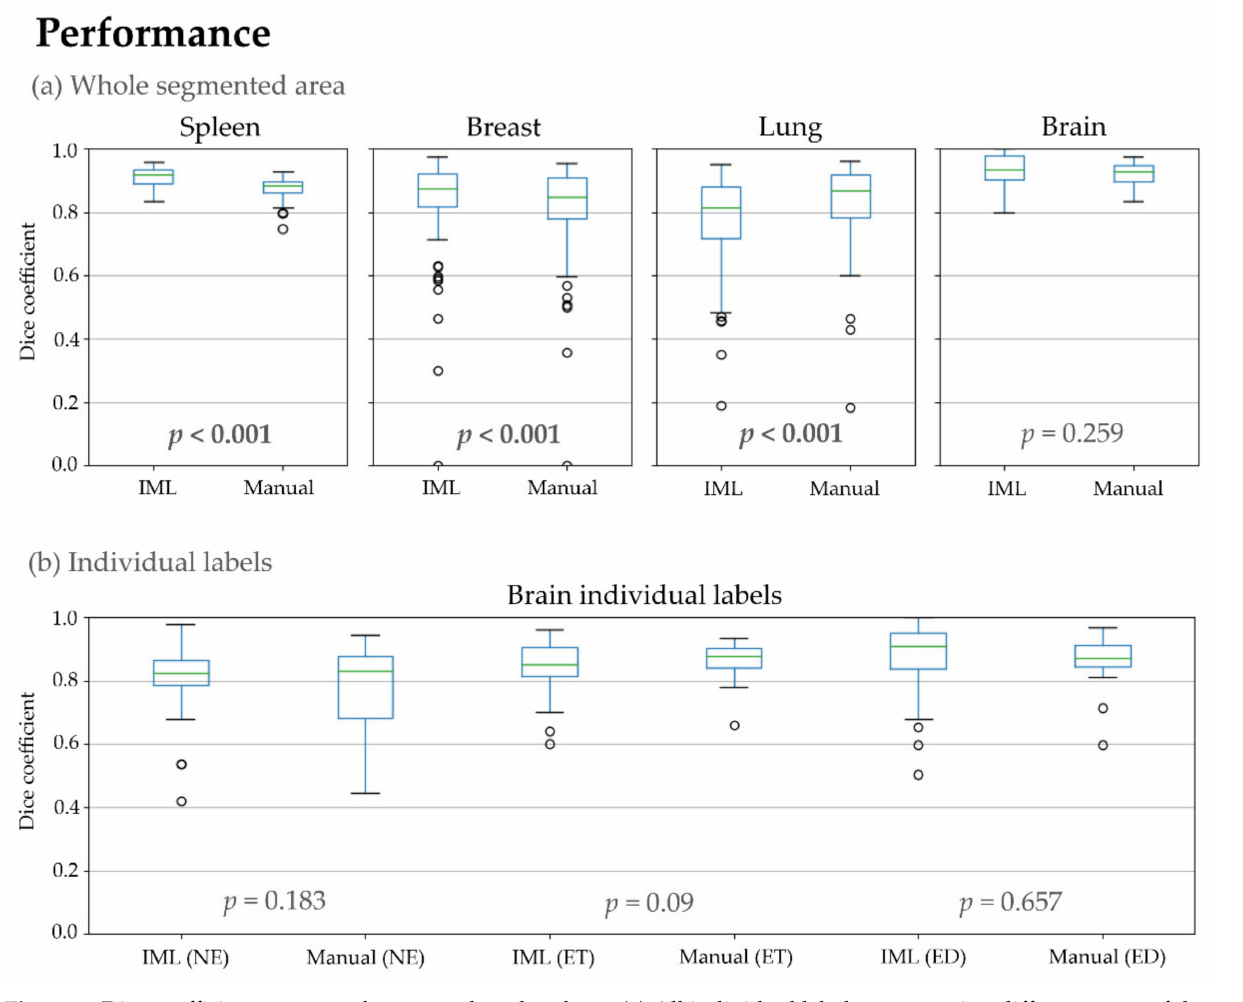
Figure 4. Dice coefficient, compared to ground truth, where: ( a ) All individual labels representing different areas of the structure counted as one; ( b ) Individual areas of